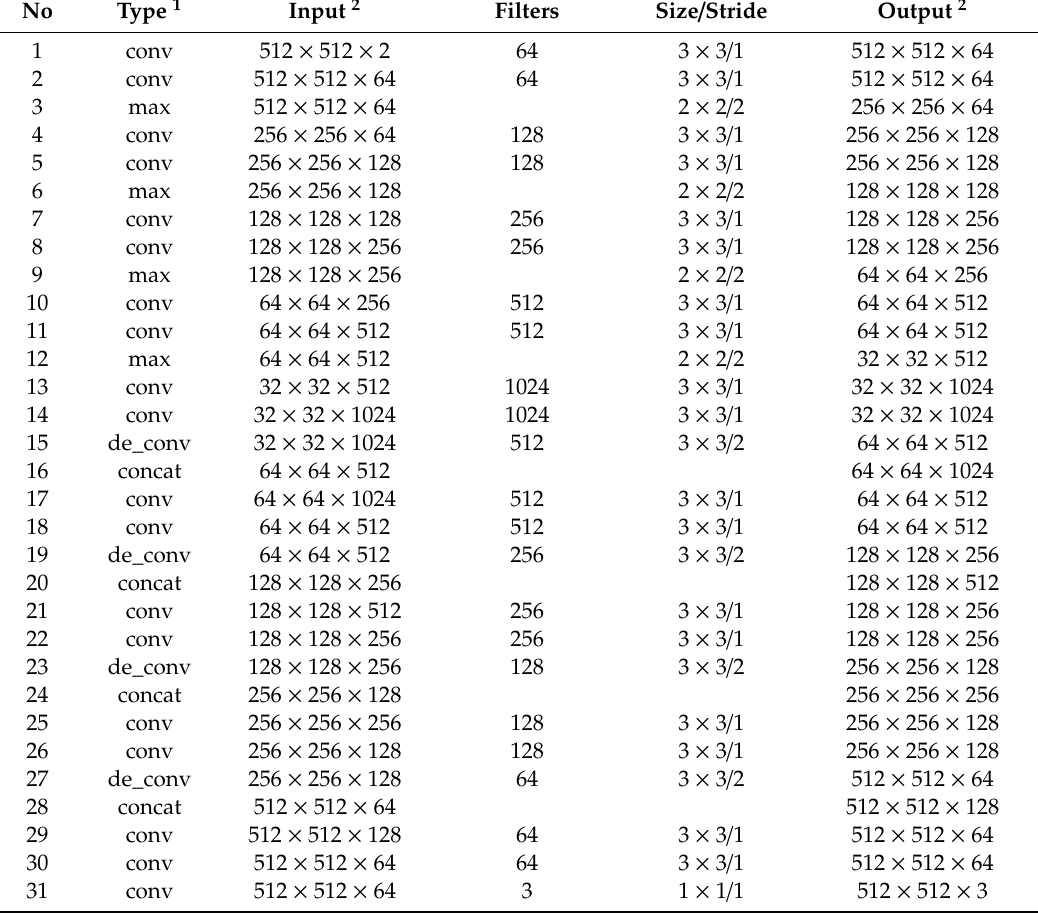
Figure 1. Architecture of the U-Net (example for 512 × 512 as the size of input data). Each white box corresponds to a multi-channel feature map. The number of channels is denoted at the top of the box. The size of feature maps for each layer is denoted on the left of the box. The gray boxes concatenated with white boxes are the copies of the feature maps from the encoder. Table 1. Fully convolutional network (U-Net) architecture set for ship